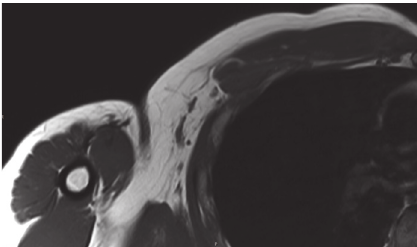
Figure 3: MRI axial T1 showing calcification inside the conjoint tendon immediately under its coracoid insertion.